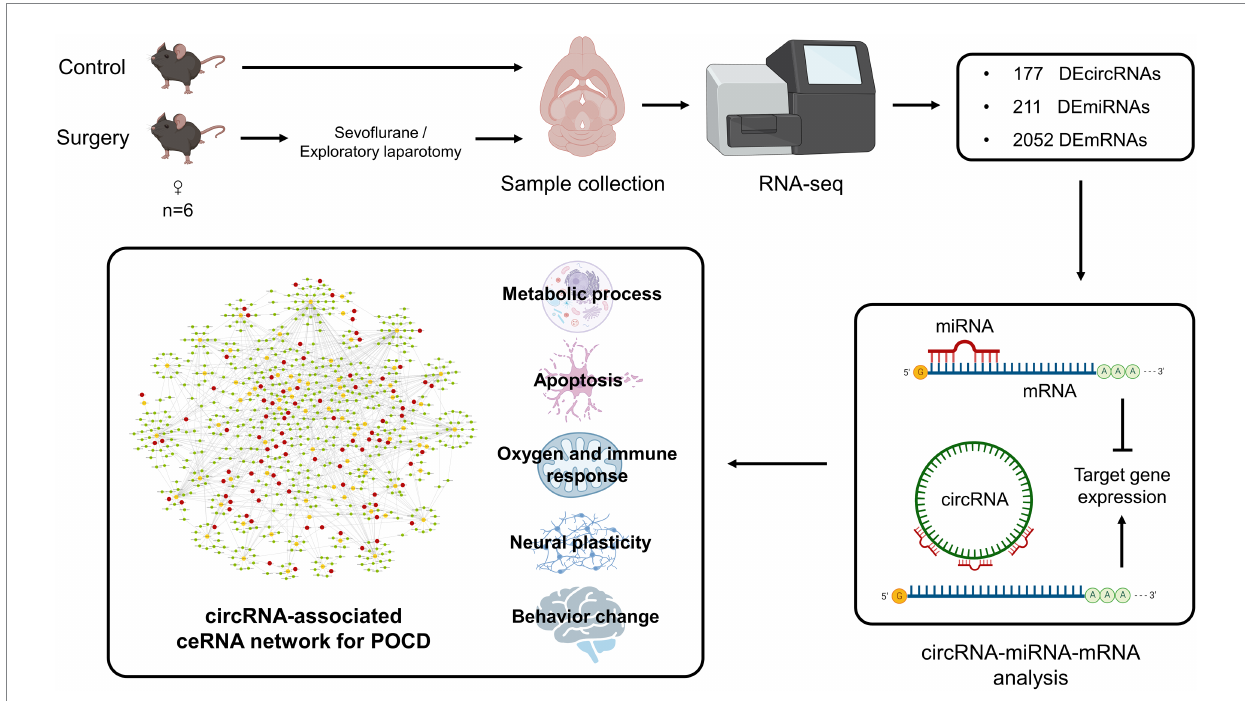
FIGURE 10 Flow chart of construction and analysis of circRNA-associated ceRNA network for the occurrence of postoperative cognitive